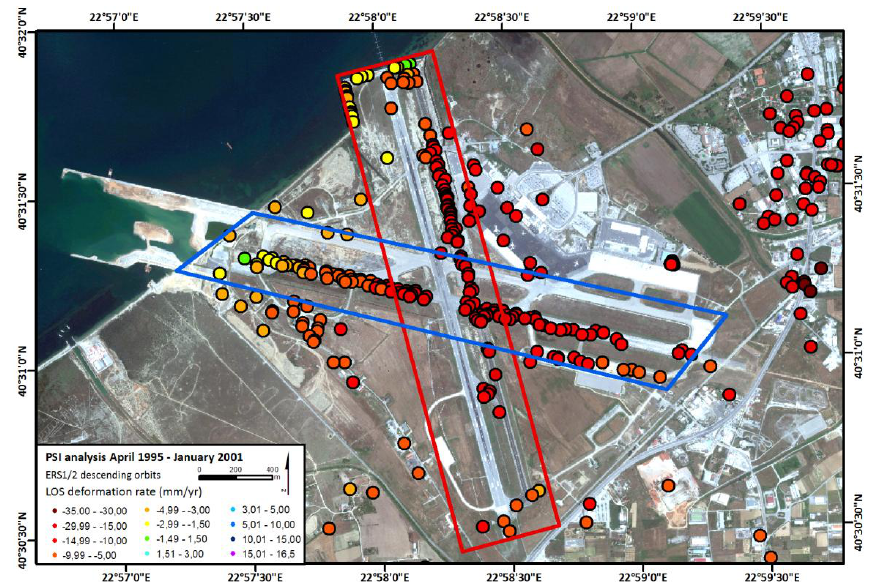
Figure 7. LOS velocity map along the runway areas of “Macedonia” Airport. PSs inside the buffer zones have been extracted and analyzed to evaluate differential settlement.